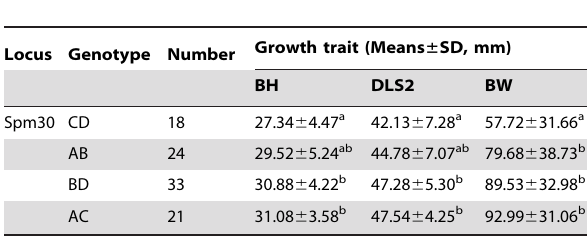
Table 4. Association analysis between microsatellite locus Spm30 and three growth traits of S.